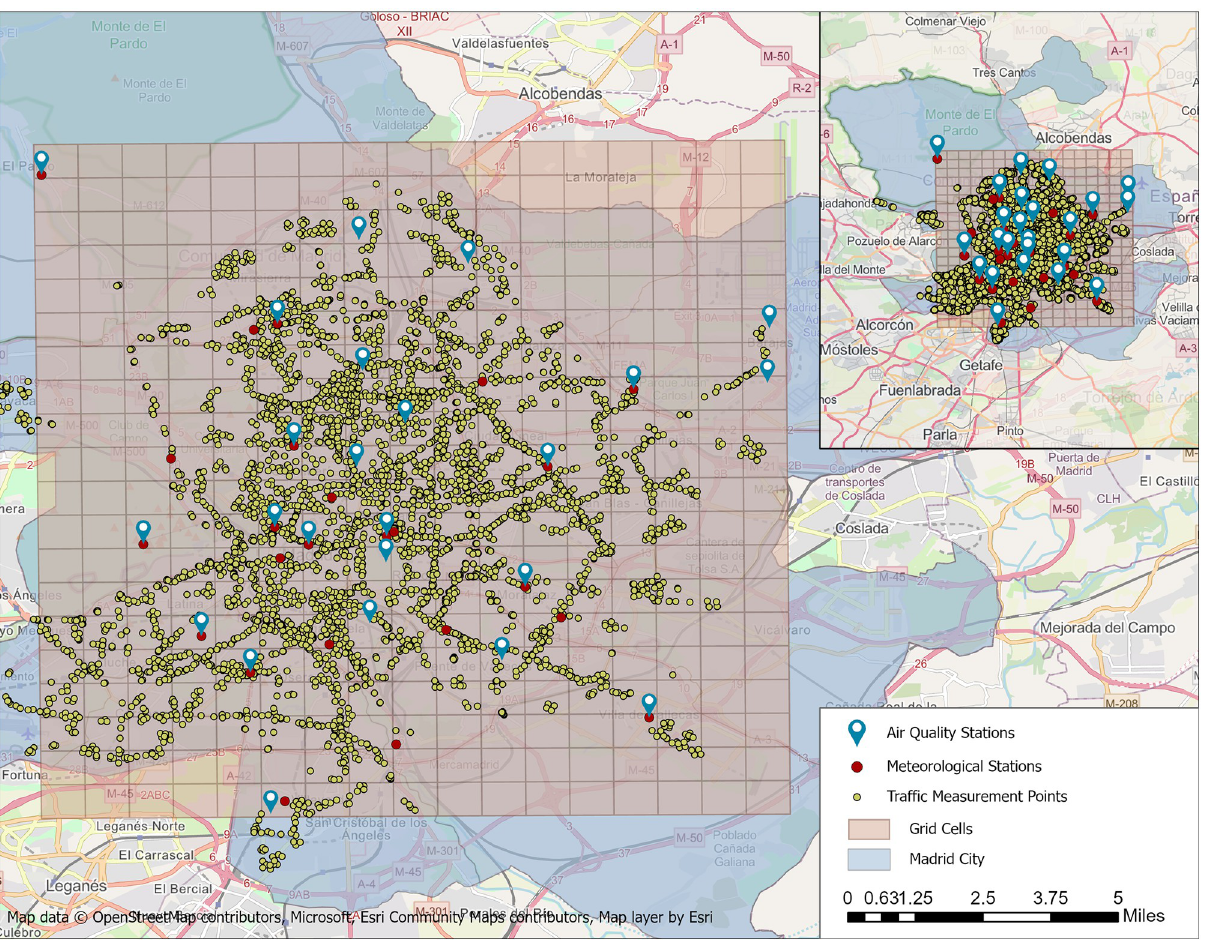
Fig 1. Air quality stations, meteorological stations, traffic measurement points and grid cells segments on the defined area of the city of Madrid (Map data © OpenStreetMap contributors, Microsoft, Esri Community Maps contributors, Map layer by Esri [50]).